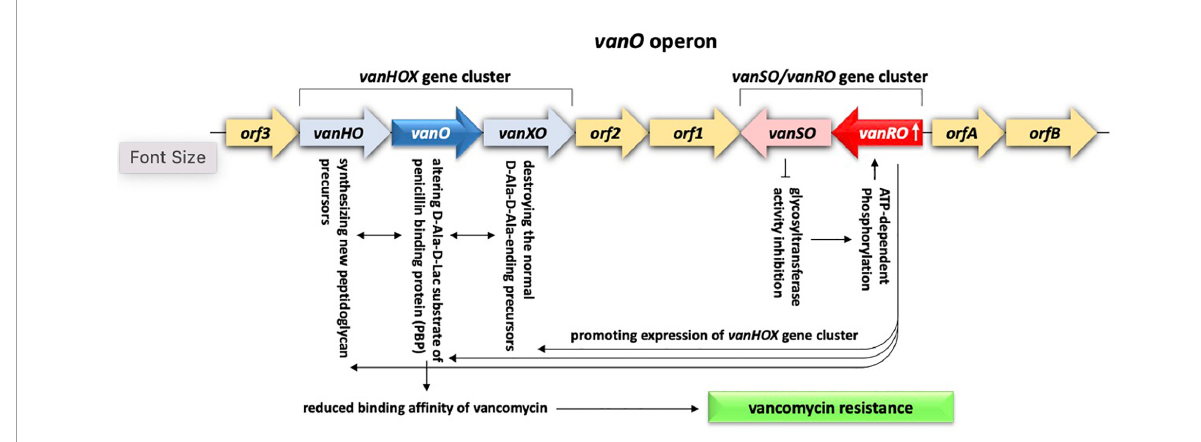
FIGURE9 Demonstration of the antibiotic target alteration system existing in rhizobiome of M. oleifera and contributed by vanRO gene encoding the response regulator (RR) and vanSO gene encoding the histidine kinase (HK) of the VanRO/VanSO two-component system. The two genes represent a cluster of the vanO operon of which activated VanRO promotes expression of the other gene cluster of vanO operon namely vanHOX The latter cluster, in turn, acts in reducing binding affinity of vancomycin, thus, confers antibiotic resistance.